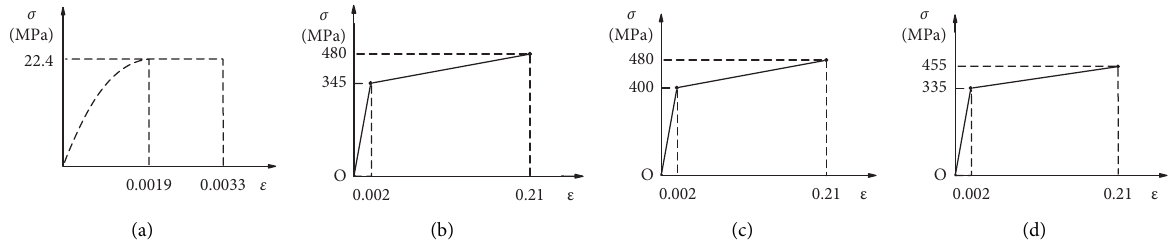
Figure 3: Constitutive relationship curves. (a) Concrete. (b) Steel plate. (c) Stud. (d) Steel